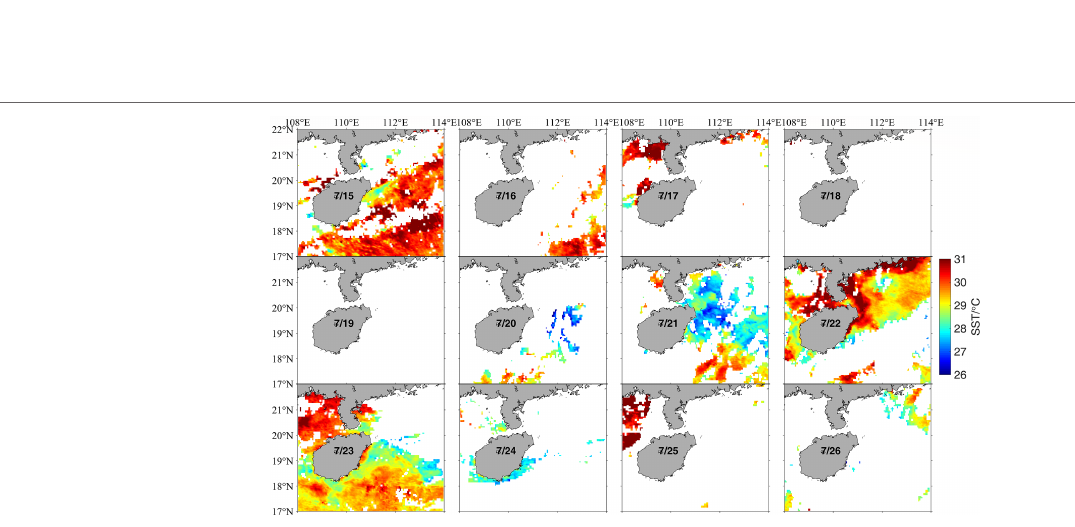
FIGURE 3 | Distribution of MODIS daily sea surface temperature (°C) from July 15 to 26.